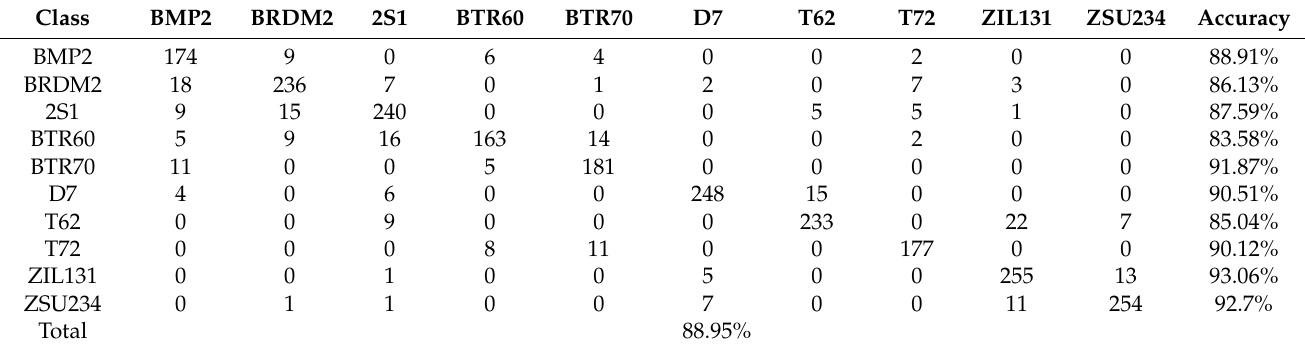
Table 3. Confusion matrix of testing results of the ADMF-IFCNN model trained on subset-20.